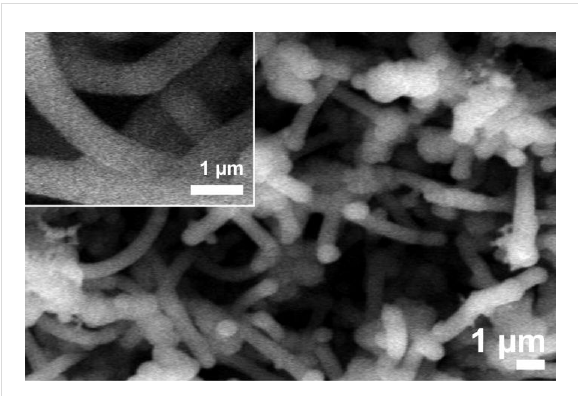
Figure 4: SEM images of NWs grown on gold-sputtered Si[111] by exposure to NPS vapor for 1 h at 650 °C.